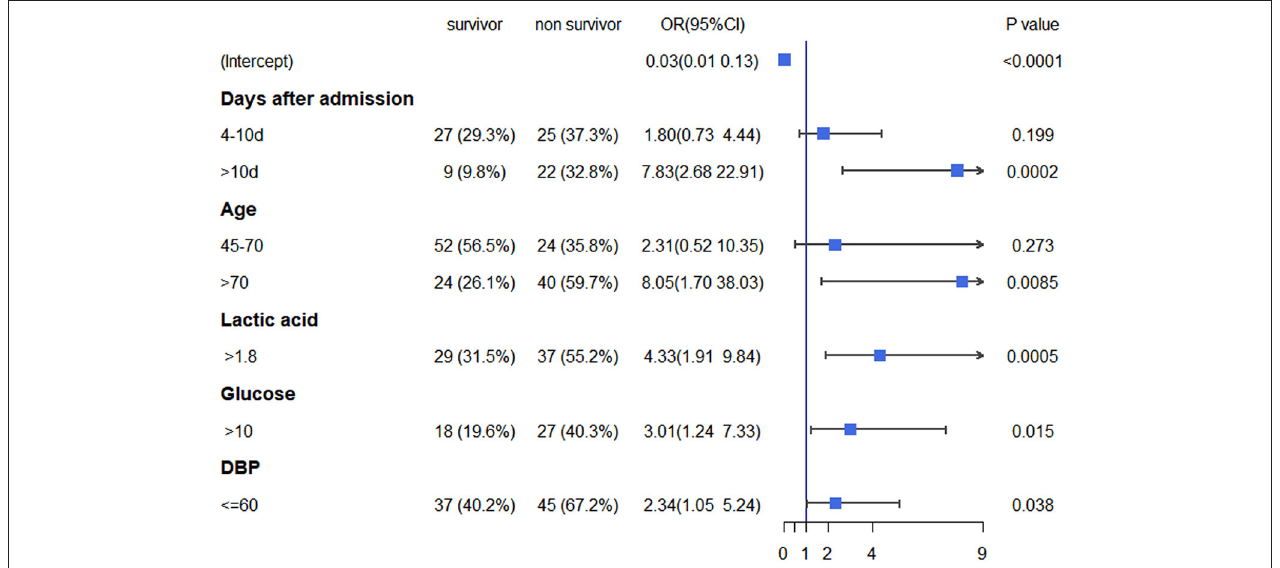
FIGURE 1 | Multivariate logistic regression analysis of in-hospital mortality based on pre-CRRT data in the training cohort. CRRT, continuous renal replacement therapy.